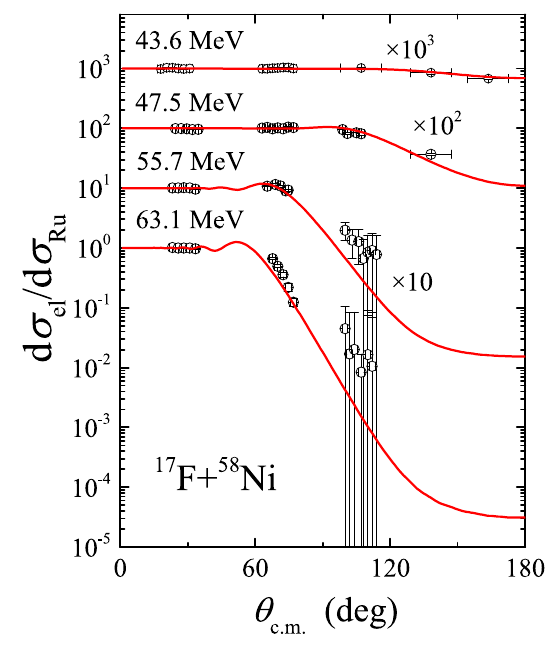
Figure 4. Angular distributions of elastic scattering of 17 F on 58 Ni at E 17 F) = 43.6, 47.5, 55.7 and 63.1 MeV. The solid lab ( curves represent the CDCC